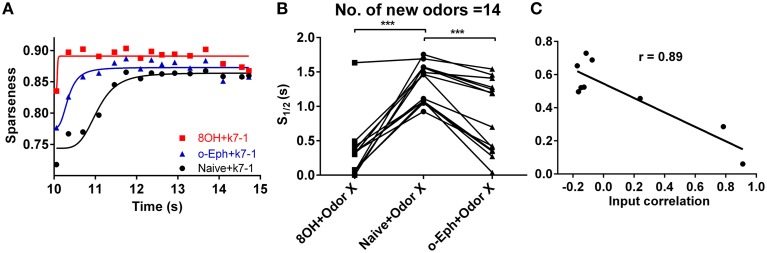
Evolution of sparseness of mitral cell network responses in naïve and experienced odor input conditions. (A) A time course plot shows the sparseness of the mitral cell network response to odor input K7-1 in the single odor input (8OH or o-Eph) experience or naive condition. The solid line represents the fitting curve described by the classical logarithmic function (see Materials and Methods). (B) 1/2 time of sparseness (S1/2) of the mitral cell network response to 17 new odor inputs in the single odor input (8OH or o-Eph) experience or naive conditions. S1/2 is the time elapsed from the first presentation of new odor inputs to the time when the sparseness reaches half of the maximum value. ***p < 0.001, one-way ANOVA with Tukey's post-hoc comparison test. (C) S1/2 of mitral cell network responses to 8OH in nine different single odor input experience conditions vs. the correlation coefficients of input strength of these nine experienced odor inputs and 8OH. The solid line represents the linear fitting curve.